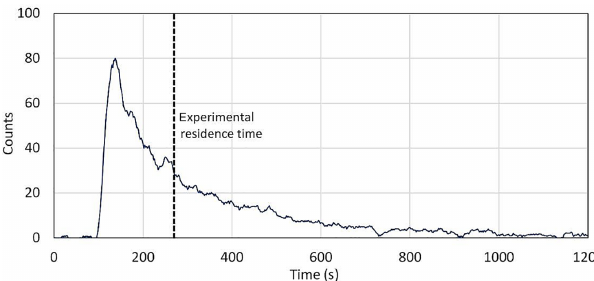
Figure 2. Example of pulse experiments for the quantification of the flow tube residence time. The pulse of toluene generated at the entrance of the flow tube at t =